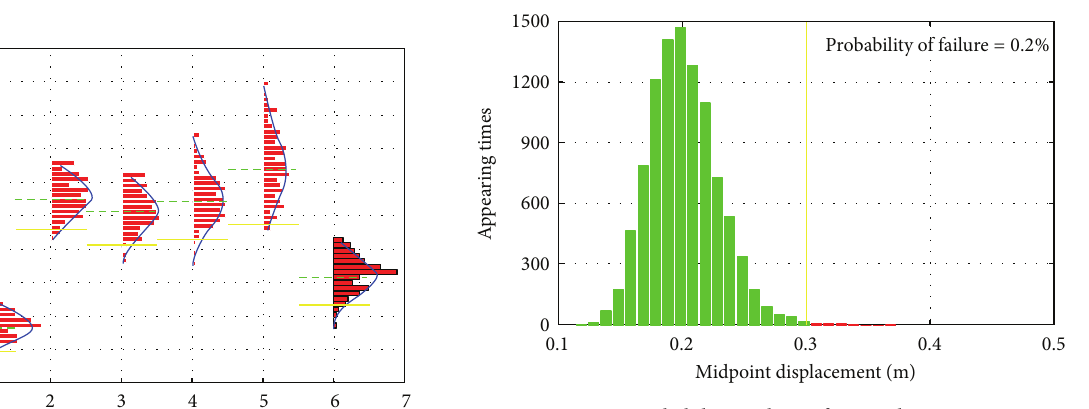
Figure 7: Reliability analysis of original